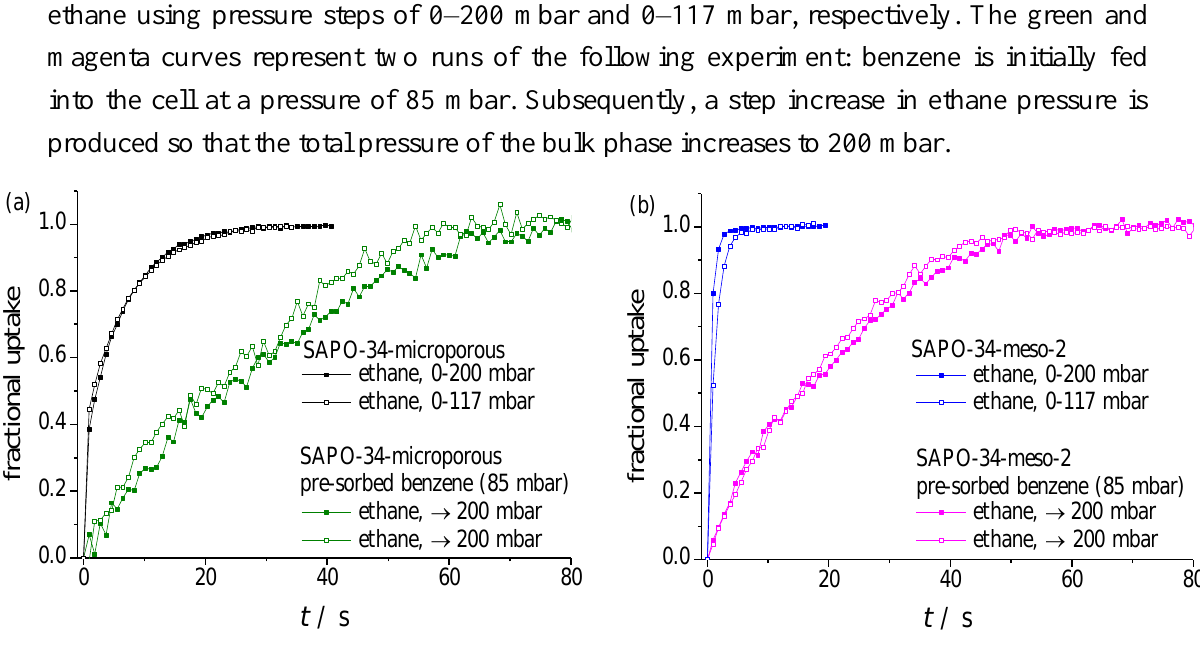
Table 3. Fitting parameters yielding best approach to the experimental data displayed in Figure 5 by implying diffusion-limited ( D in Table 3, fit to Equation (1)) and barrier-limited ( α in Table 3, fit to Equation (2)) uptake and release for ethane in SAPO-34-microporous and SAPO-34-meso-2. Fitting parameters which, by comparison between experimental measurement and theoretical dependence, may be considered as physically meaningful quantities ( i.e ., intraparticle diffusivities or surface permeabilities, see the examples given in Figure 6) are printed in